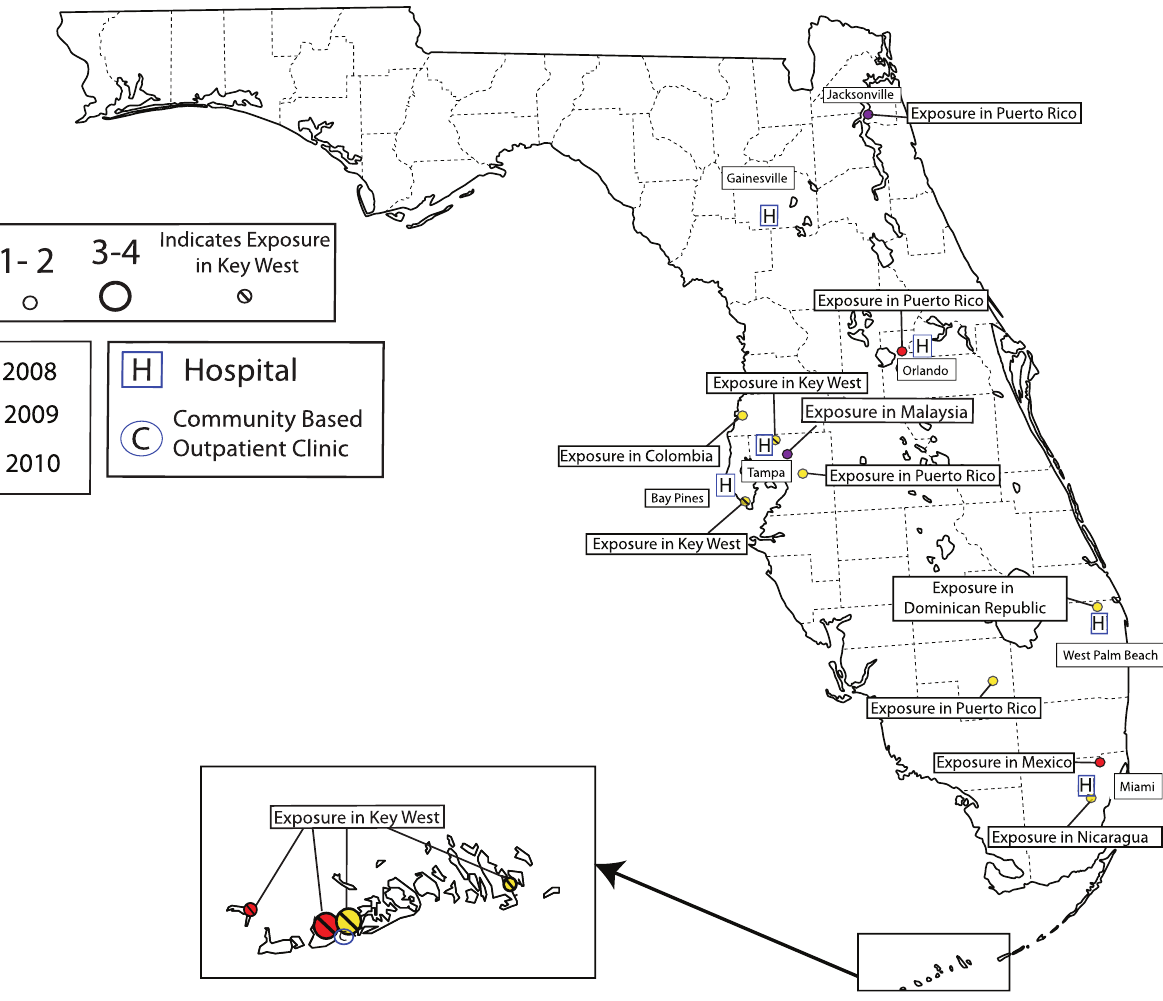
Figure 2. VA dengue cases in Florida. Location of dengue cases (confirmed/probable/suspected) with place of exposure presenting to Florida VAs based on zip code of residence, 2007–2010 (No cases were identified in